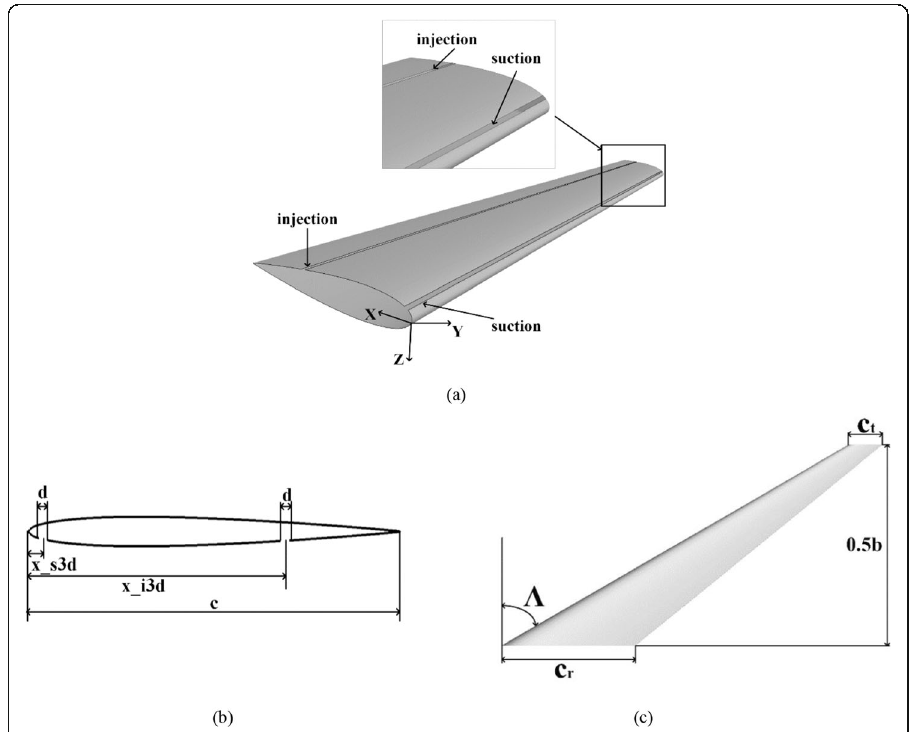
Fig. 23 Diagrams of configurations for a 3-D wing with suction and injection